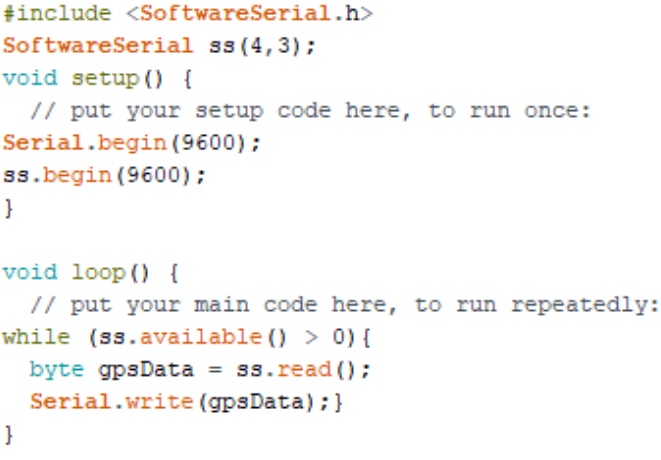
Figure 15. Sketch Uploaded to Arduino Uno Board. When the GPS module is connected to the board, it sends the received data to a serial port. On the serial monitor, the data are viewed in the form of NMEA sentences. When it starts, the data received are not complete, as shown in the text box. It takes (10 to 15 mins) to the module after a cold restart to obtain and lock in the data. The data are shown in another text box.